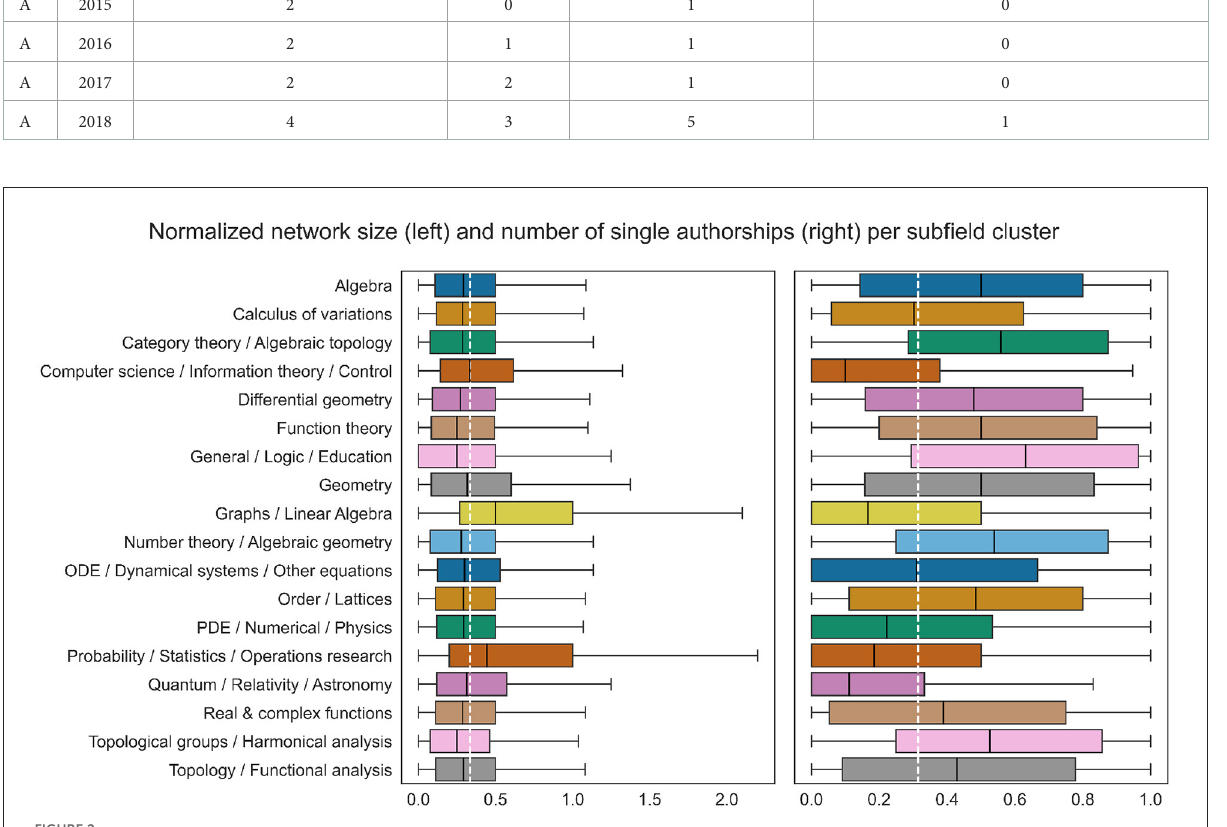
FIGURE2 Differences in the value distributions of the target variables between subfield clusters. The target variables were normalized by dividing each by the total number of publications, as the latter is strongly correlated with the target variables and at the same time subfield specific. The white dashed line marks the normalized mean of the entire data. The overall difference is statistically significant with p -value 0.01, measured with one-way